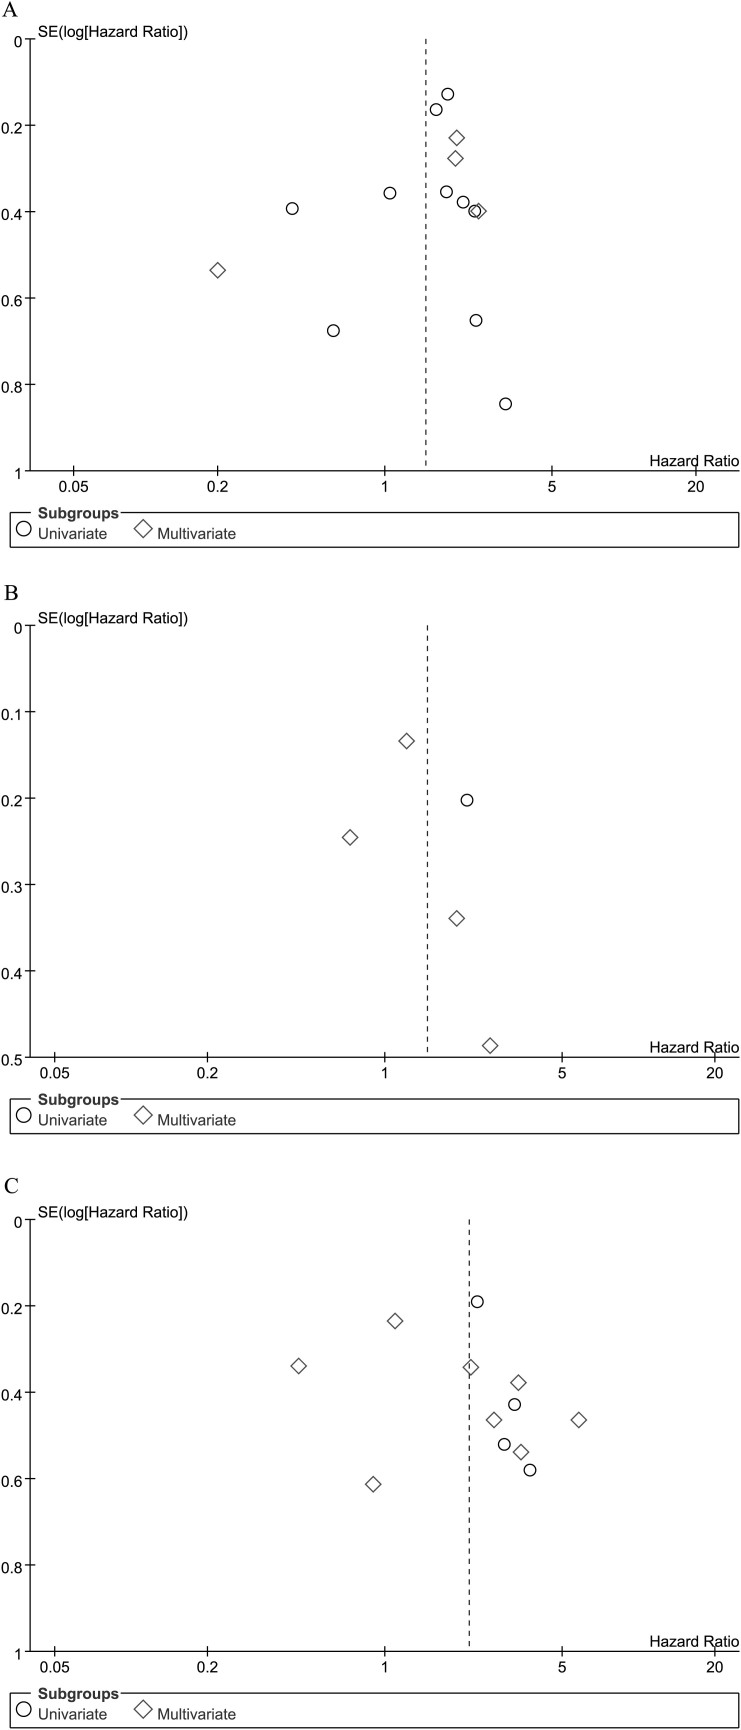
Funnel plot for the evaluation of potential publication bias in the impact of WT1 on overall survival (A), disease-specific survival (B) and disease-free survival/progression-free survival/relapse or recurrence-free survival (C) of patients with solid tumors.The funnel graph plots the log of HR against the standard error of the log of the HR (an indicator of sample size). The circles indicate the individual studies in the meta-analysis. The line in the center represents the metaHR.